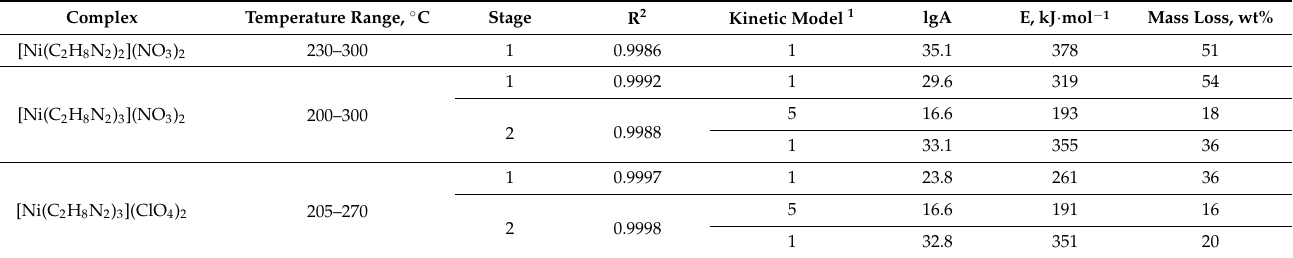
Results for the modeling of the thermal decomposition of [Ni(C 2 H 8 N 2 ) 2 ](NO 3 ) 2 , [Ni(C 2 H 8 N 2 ) 3 ](NO 3 ) 2 and [Ni(C 2 H 8 N 2 ) 3 ](ClO 4 ) 2 complexes (5 mg, helium, 20 mL · min − 1 , 5 ◦ C · min − 1